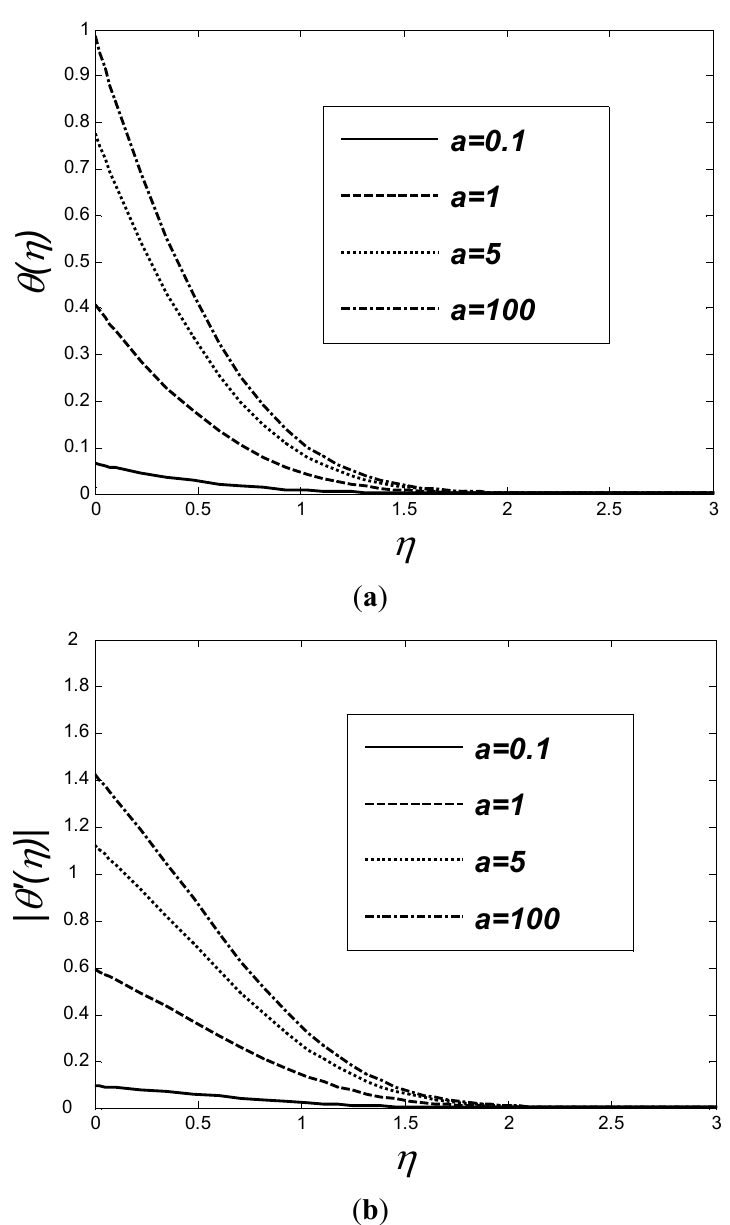
= 0.2, Ec = 0 and M = w